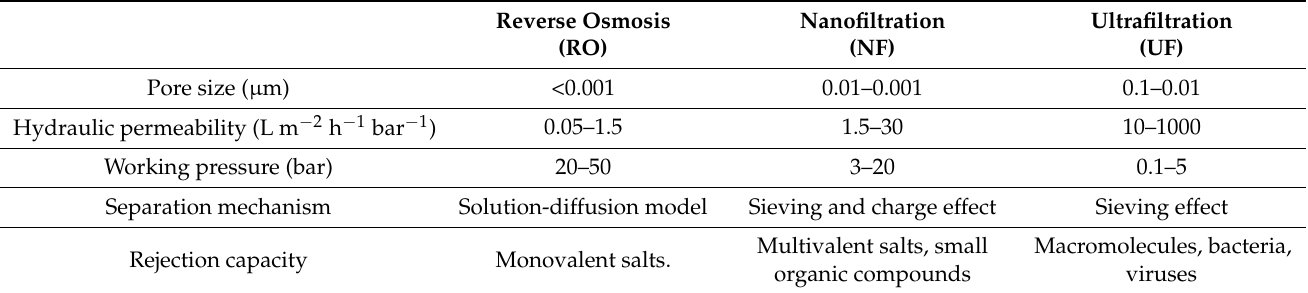
Table 1. Main characteristics of RO, NF, and UF membranes. Adapted from